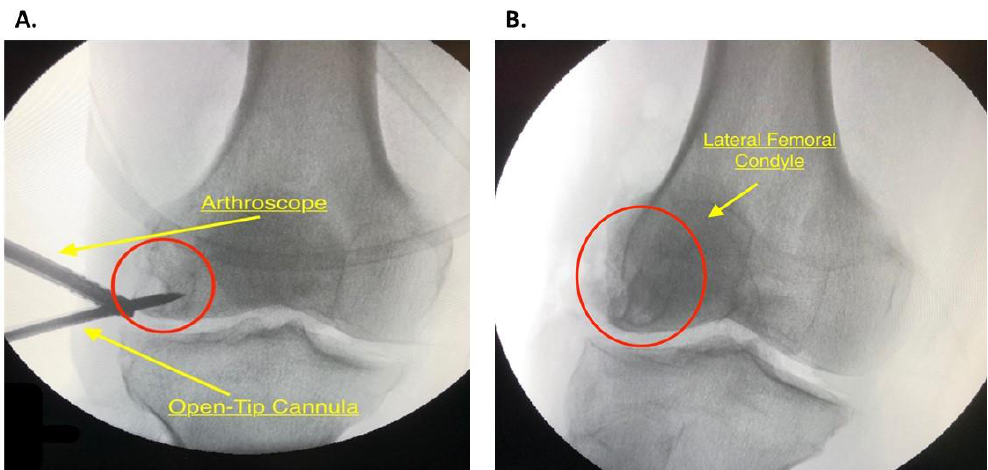
Figure 5. ( A ) Fluoroscopic image of the open-tip delivery cannula injecting the biologic mixture into the decompressed Subchondral Cyst (SC) (red circle) with arthroscopic guidance. ( B ) Final fluoroscopic image of the right knee after injection of the biologic mixture into the SC (red circle).